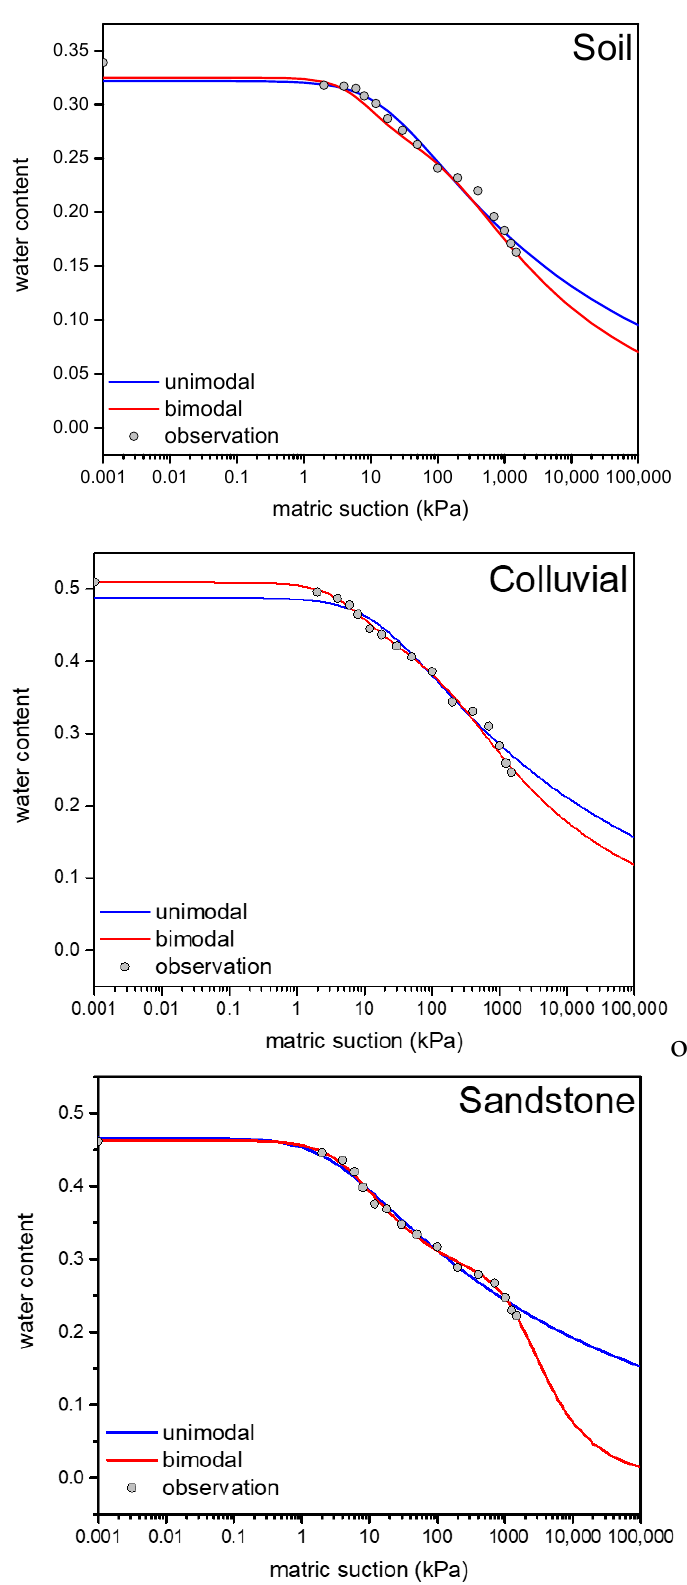
Figure 3. Optimal SWRC fitting for unimodal and bimodal of soil, colluvial, and sandstone.